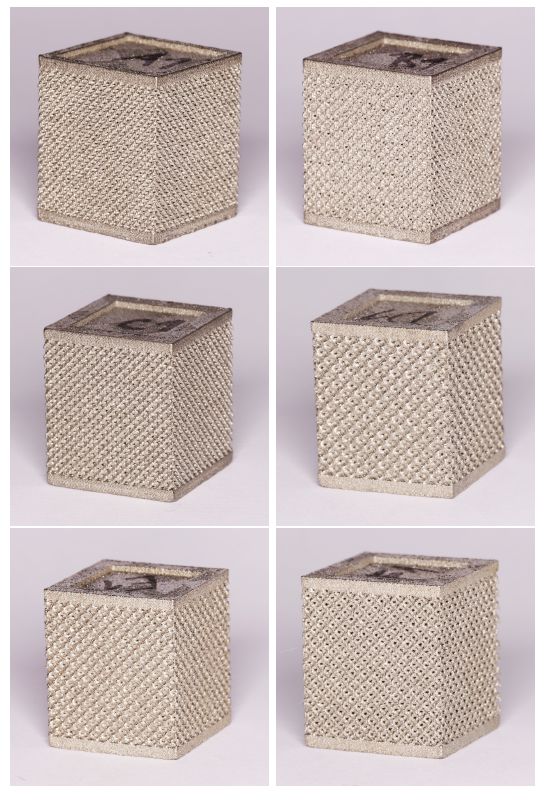
Figure 2. Real manufactured specimens A-F used for the uniaxial compression test.